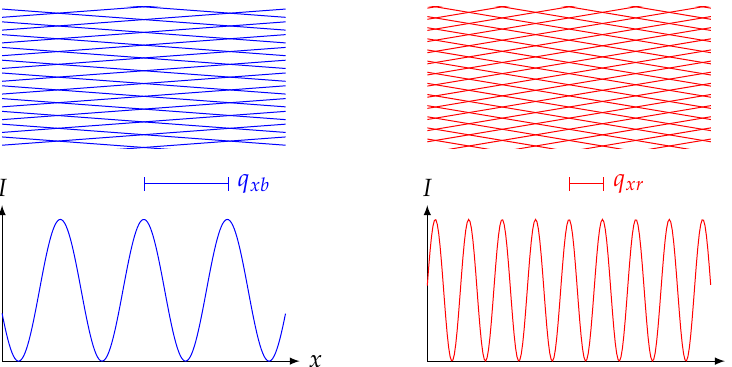
Figure 3. Intensity distributions recorded by a row of the detector array along the x axis for a series of wavefronts with different wave numbers, separated for clarity. Periodicity of the interference fringes for each wavefront is given by q xb and q xr . In a measurement, the detector records the sum of intensity distributions for all wavefronts irradiating